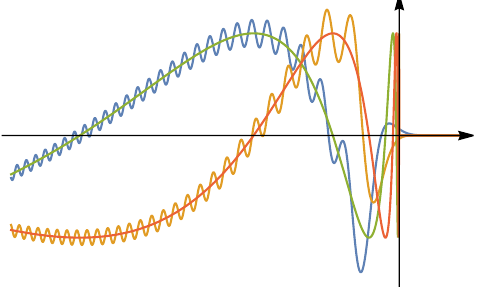
Figure 3. Schematic plot of | ψ ( U, V 0 ) | as a func- tion of U according to eq. (3.10). The step func- tion (green) corresponds to the limit λ 2 → 0 .